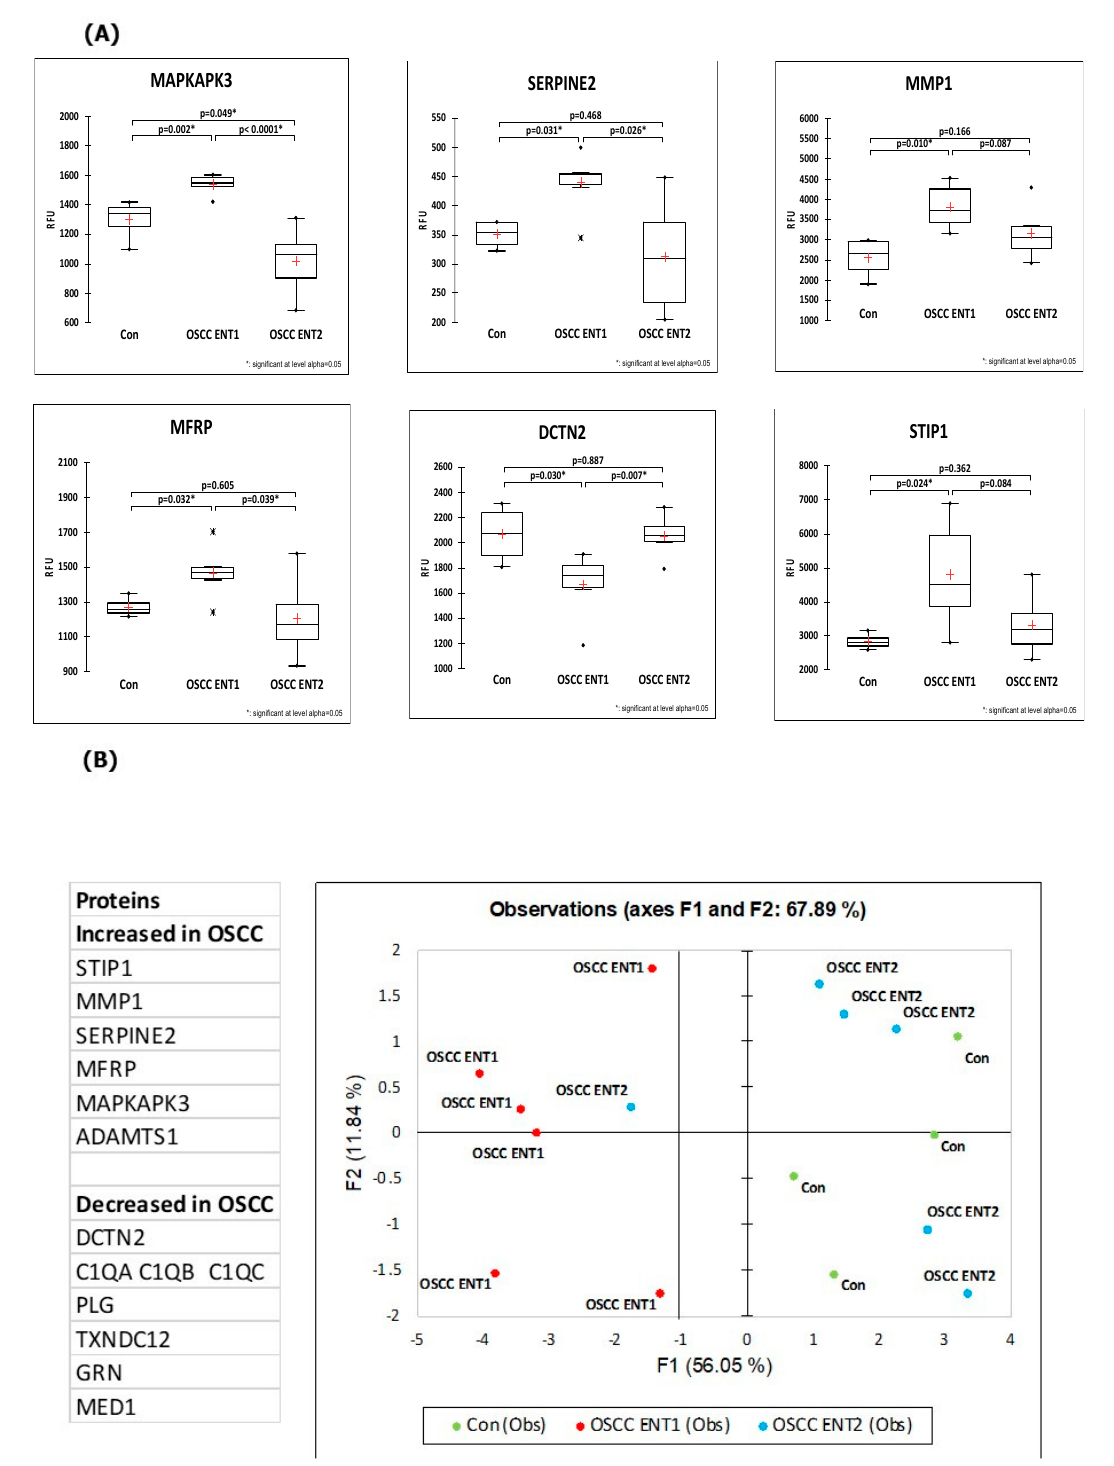
Figure 4. ( A ) The 12 OSCC-associated proteins reversed in expression after surgical resection. ( A ) Box Whisker plots for MAPKAPK2, SERPINE2, MMP1, MFRP, DCTN2 and STIP1 protein expression levels in pre-resection OSCC (OSCC ENT1), post-resection OSCC (OSCC ENT2) cases and healthy controls (Con). Data derived are shown as a Box Whisker plot with the mean expression depicted as + and median expression indicated by a horizontal line. The expression levels were determined by SOMAscan from patient serum. ( B ) PCA analysis using the 12 reversed OSCC- associated proteins. The names of all 12 proteins are